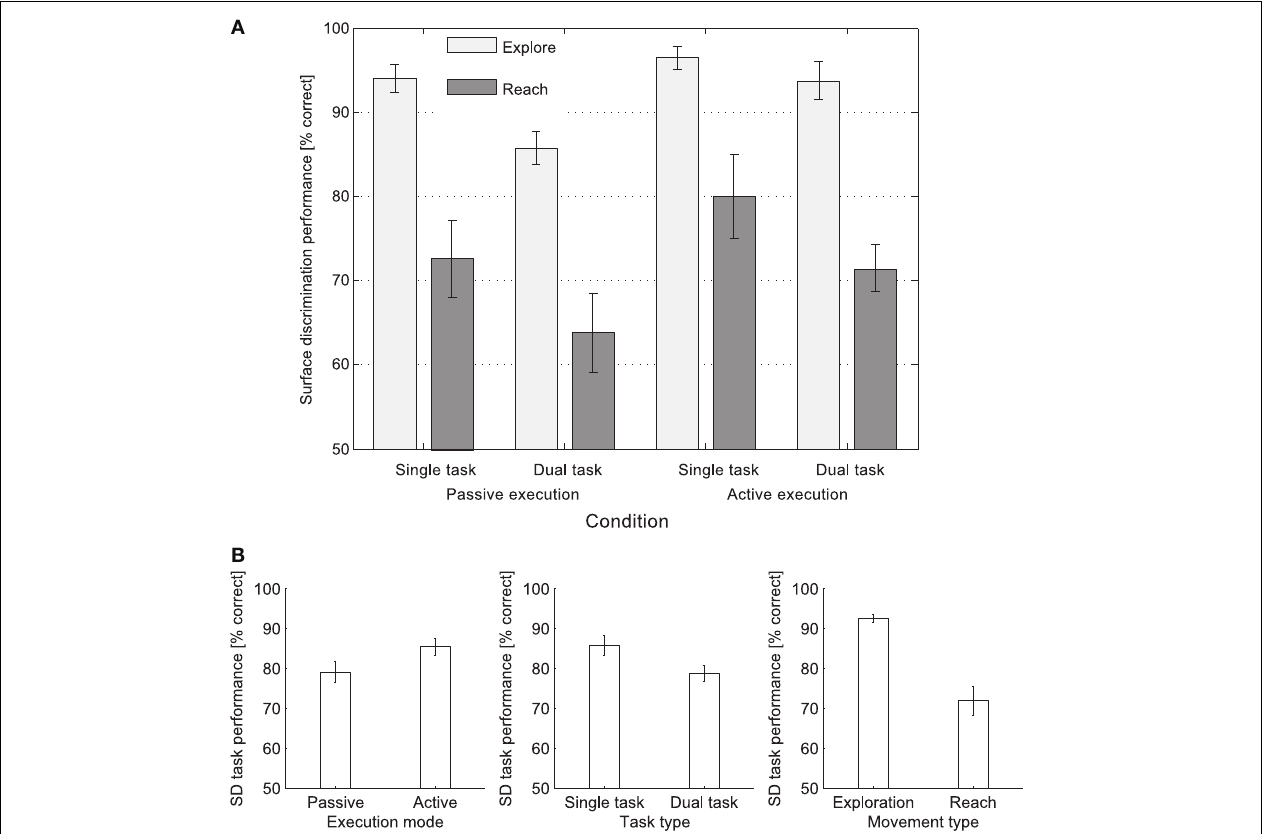
FIGURE 6 | (A) Percentages of correct responses for the different conditions in the SD task. (B) Significant main effects of Execution mode, Task type, and Movement type in the SD